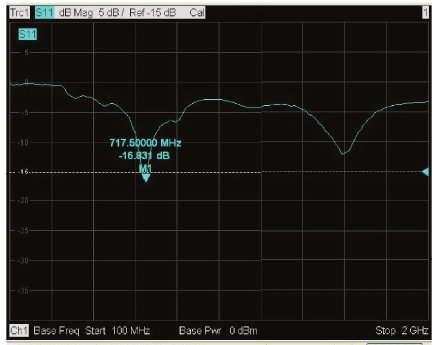
Figure 9: Magnitude versus frequency (measurement).